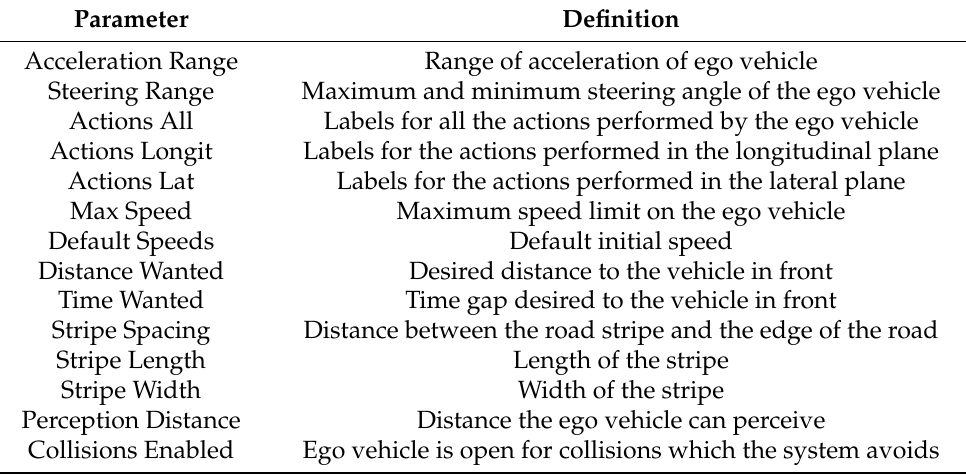
Table 1. Parameters and their quantitative meaning.